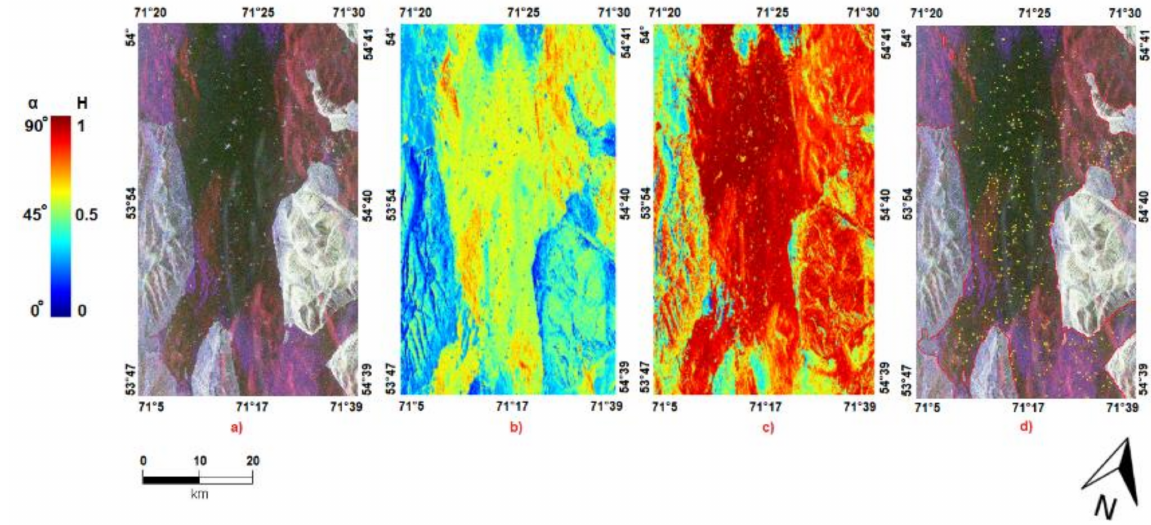
Figure 3. Output images for Nuugaatsiaq, 15 August 2015 01:26: ( a ) Pauli RGB image, ( b ) alpha image in a 5 × 5 window, ( c ) entropy image in a 5 × 5 window, and ( d ) visual identification of icebergs and land mask. Yellow dots are icebergs. The red line represents the shoreline. Reprinted with permission from ref. [22] Copyright 2020 Remote